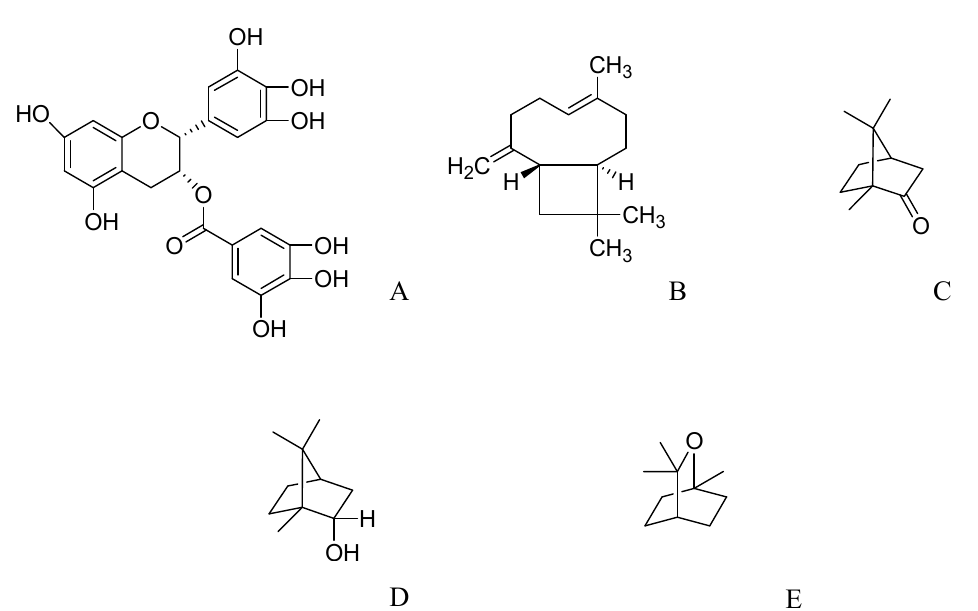
Figure 3. The molecular structures of epigallocatechin-3-gallate ( A ), caryophyllen ( B ), camphor ( C ), borneol ( D ), and 1,8-cineol ( E